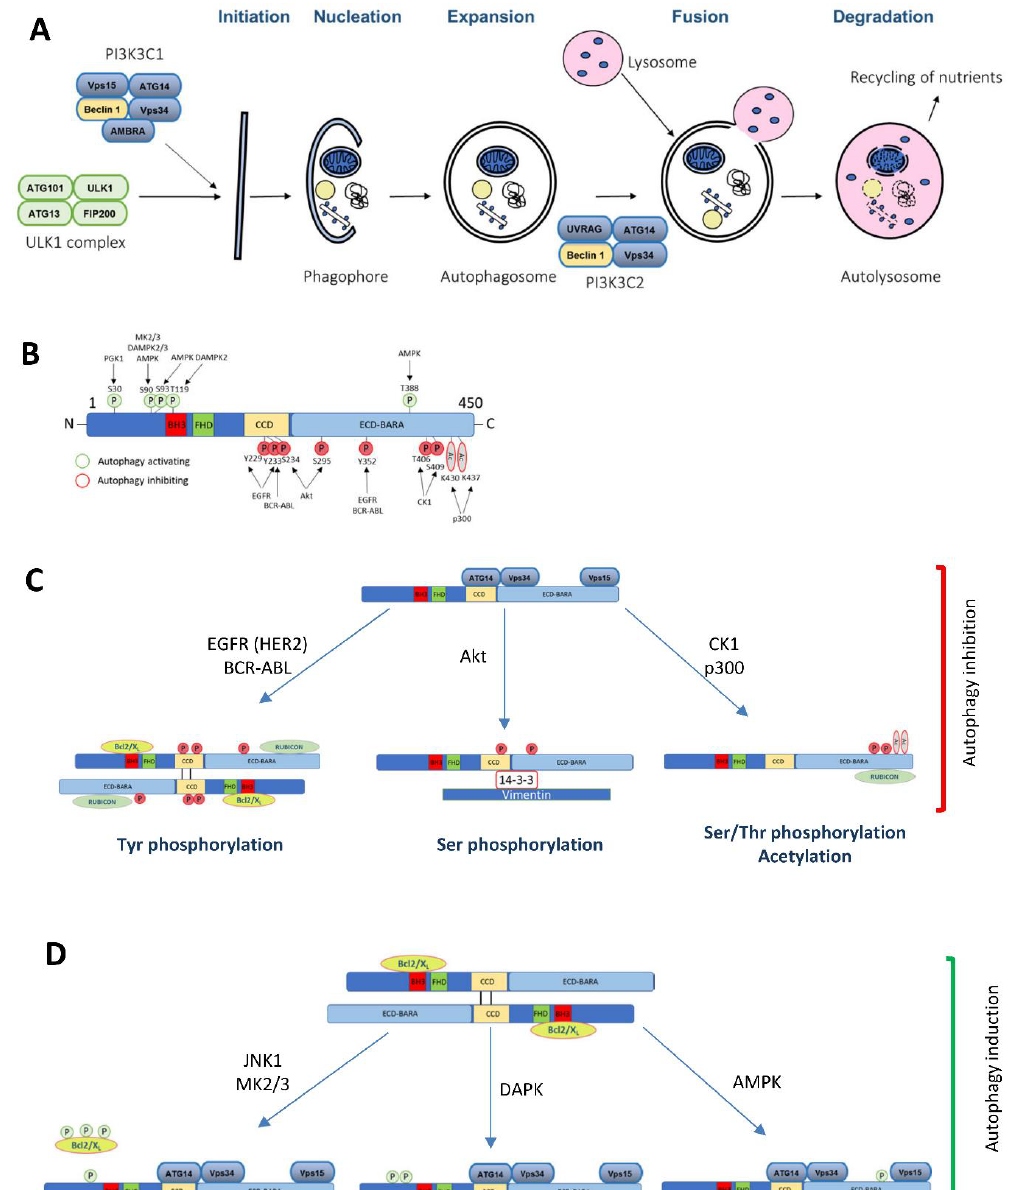
Figure 1. The Beclin 1 function in autophagy and the role of its post-translational modifications implicated in cancer. ( A ) A diagram of the macroautophagy pathway highlighting the complexes where Beclin 1 is involved in. ( B ) A schematic illustration of the Beclin 1 post-translational modifications implicated in cancer and its consequences in autophagy ( C ) inhibition or ( D ) induction.